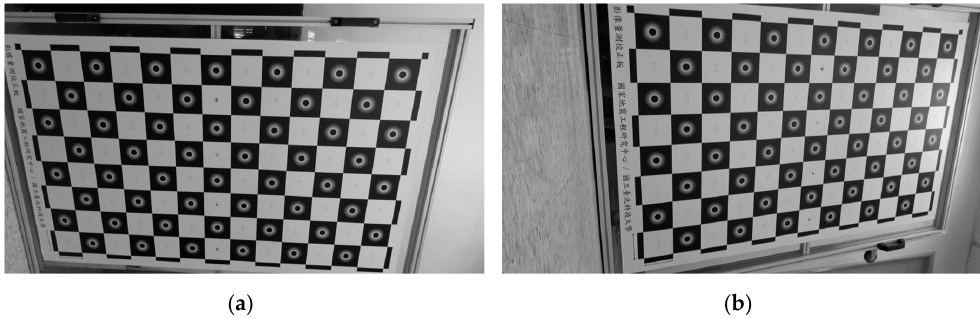
Figure 10. Selected samples of video snapshots for intrinsic calibration. The calibration photos are used for the first stage of the two-stage calibration approach. ( a ) Video snapshot of the left camera. ( b ) Video snapshot of the right camera.